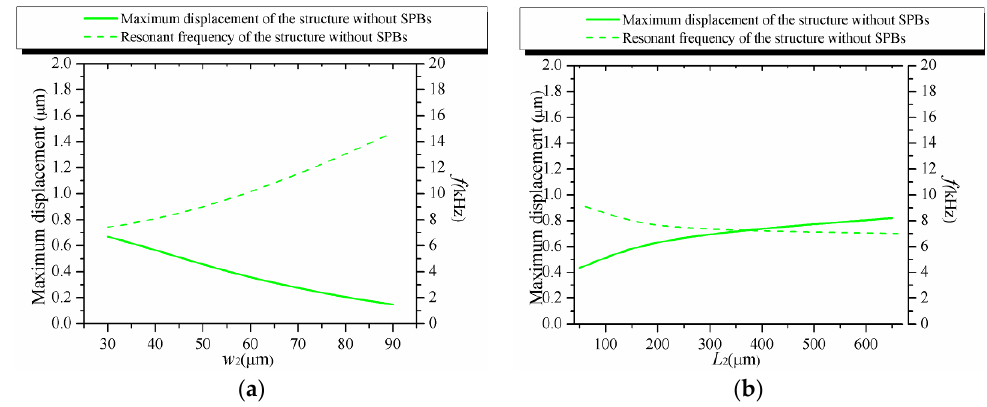
Figure 11. The structure without SPBs.